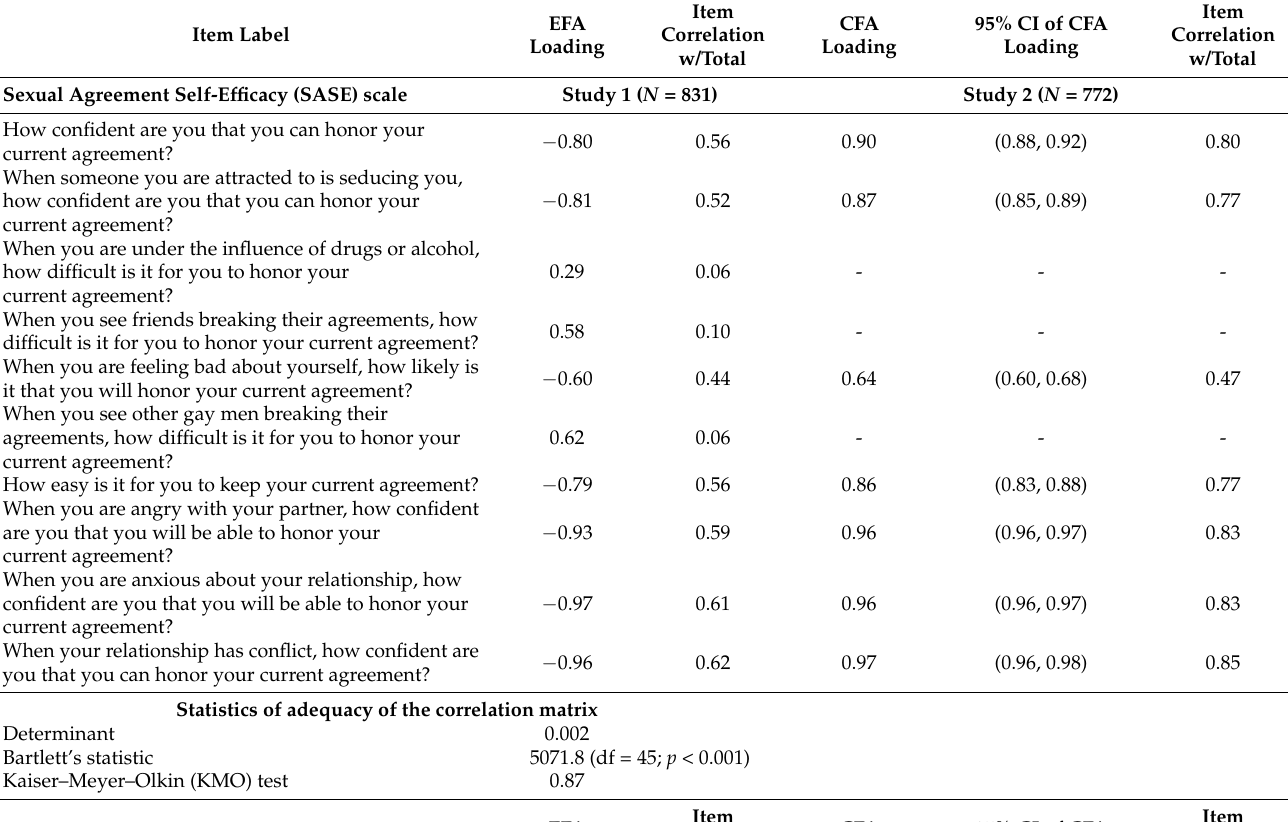
Table 3. Standardized Factor Loadings from Exploratory and Confirmatory Factor Analyses and Item Correlation with Total. Item Label